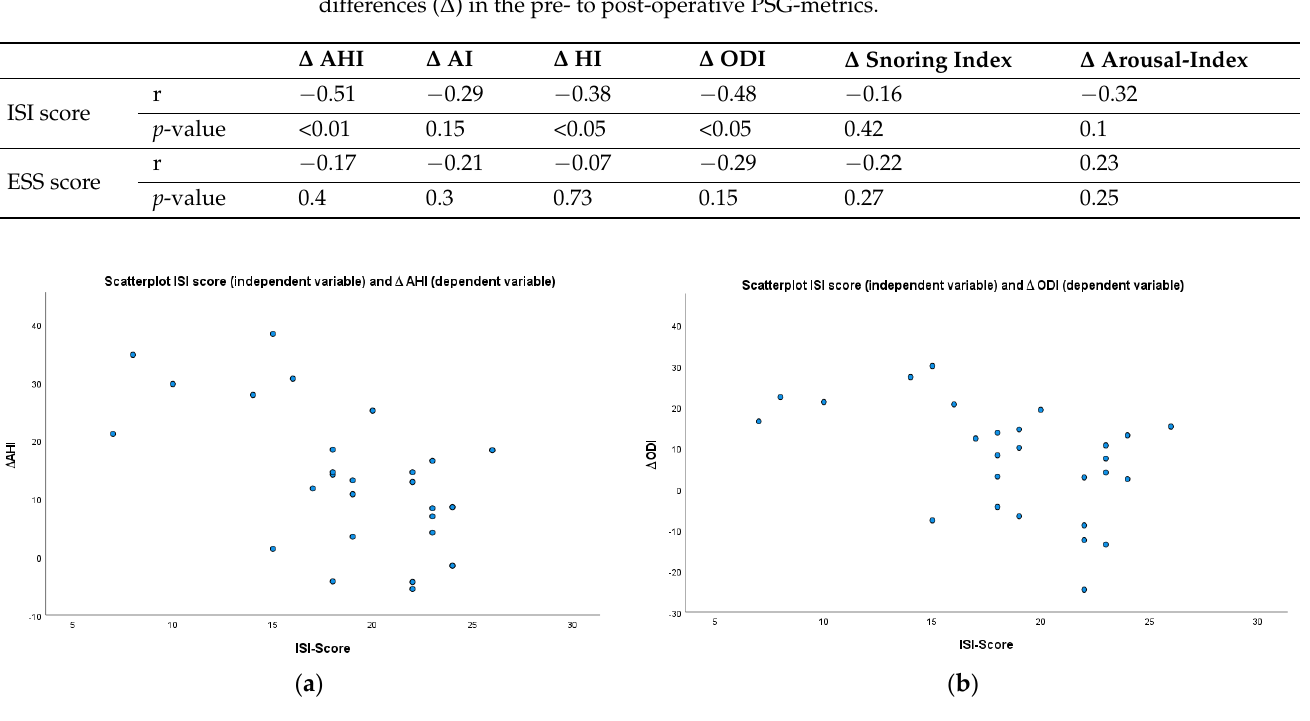
Figure 2. Scatterplot for the preoperative ISI score (independent variable) and ( a ) ∆ AHI and ( b ) ∆ ODI (dependent variable).